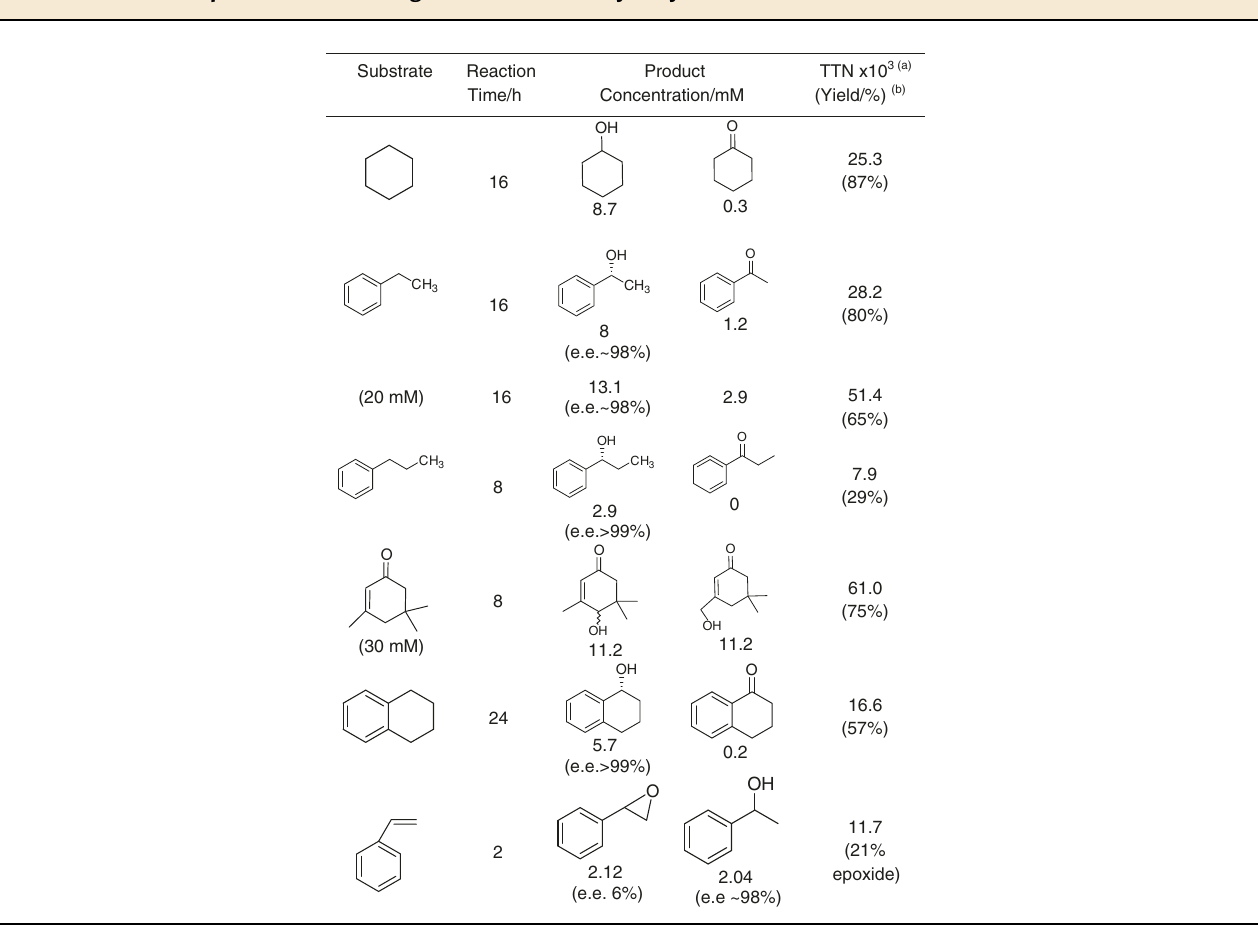
Table 1 Substrate scope of tandem heterogeneous and biocatalytic